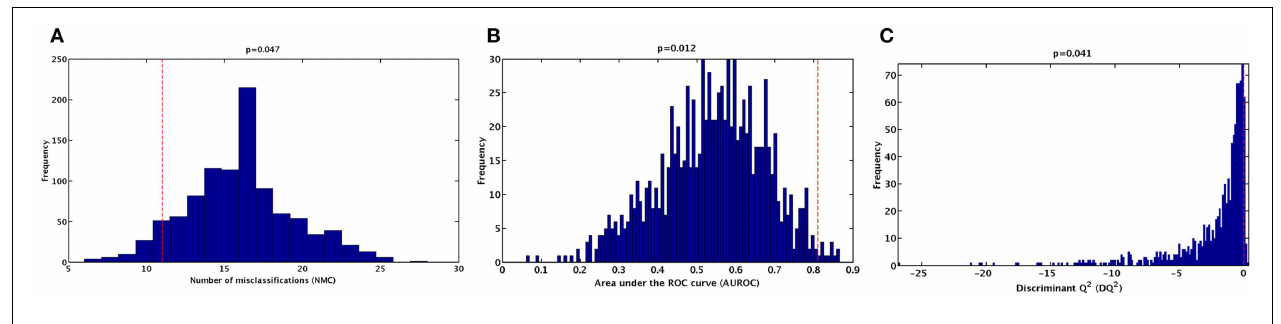
FIGURE 2 | Distribution of (A) number of misclassifications (NMC), (B) area under the ROC curve (AUROC), (C) and discriminant Q2 ( DQ2 ) values under their respective null hypothesis as estimated by